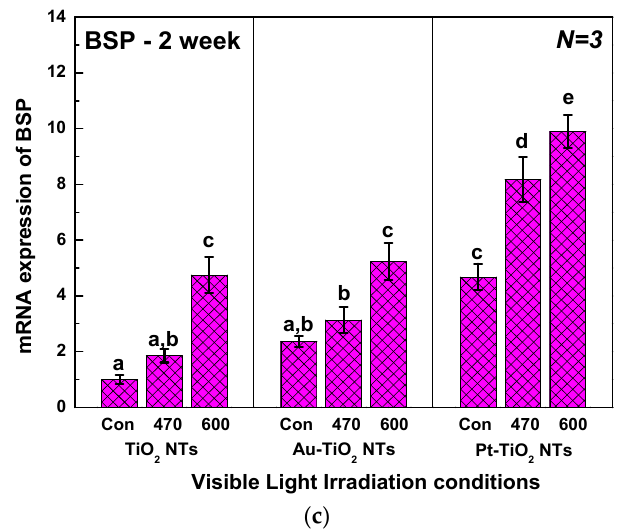
Figure 9. Quantitative real-time PCR analysis for ( a ) ALP, ( b ) OPN, and ( c ) BSP of TiO 2 NTs, Au – TiO 2 NTs and Pt – TiO 2 NTs under 470 and 600 nm visible light irradiation (“Con”: No irradiation, “470”: 470 nm irradiation, “600”: 600 nm irradiation) (in each graph, entries with the same lowercase letters were not significantly different as determined by one-way ANOVA at α = 0.05).